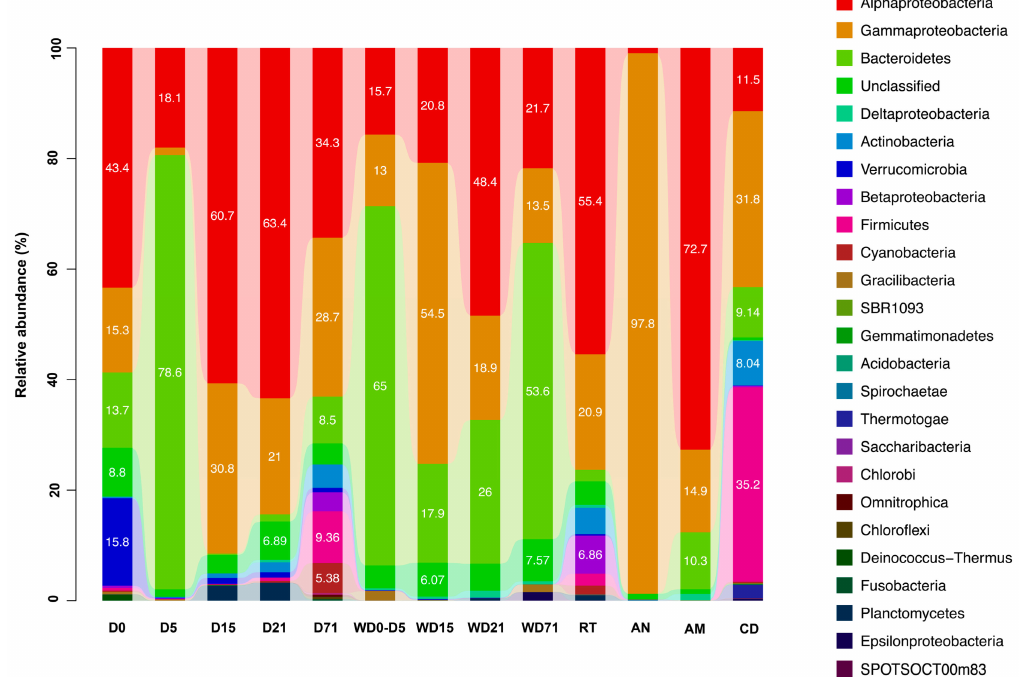
Figure 5. Relative abundance of bacterial phyla and Proteobacterial classes in all sample categories ( Sparus aurata larvae, rearing water and feeds) D: day, AM: Artemia salina metanauplii, AN: Artemia salina nauplii, CD: commercial diet, RT: rotifers, W: water